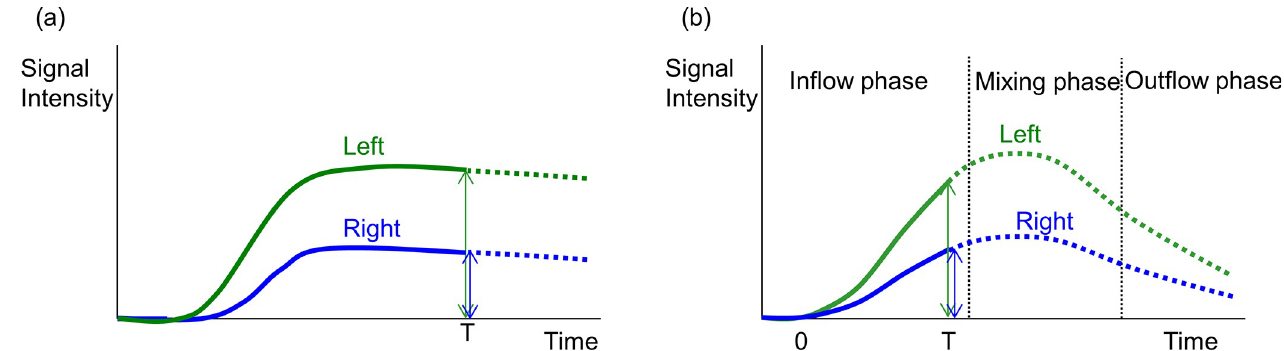
Fig 2. Kinetic model of the signal intensity of agents in each modality. The signal intensity curve for radioactive particles trapped in the right and left pulmonary bed separately by scintigraphy is shown in (a). The ratio of the signal intensity in each lung is maintained over time. However, the signal intensity curve for the contrast agent in each lung as measured by angiography shows time-dependent changes that depend on the pulmonary circulation, and thus the right-to-left lung distribution ratio also changes (b). Therefore, the measurement time window for pulmonary blood distribution should be set to before the contrast agent passes through the pulmonary capillary bed to the left